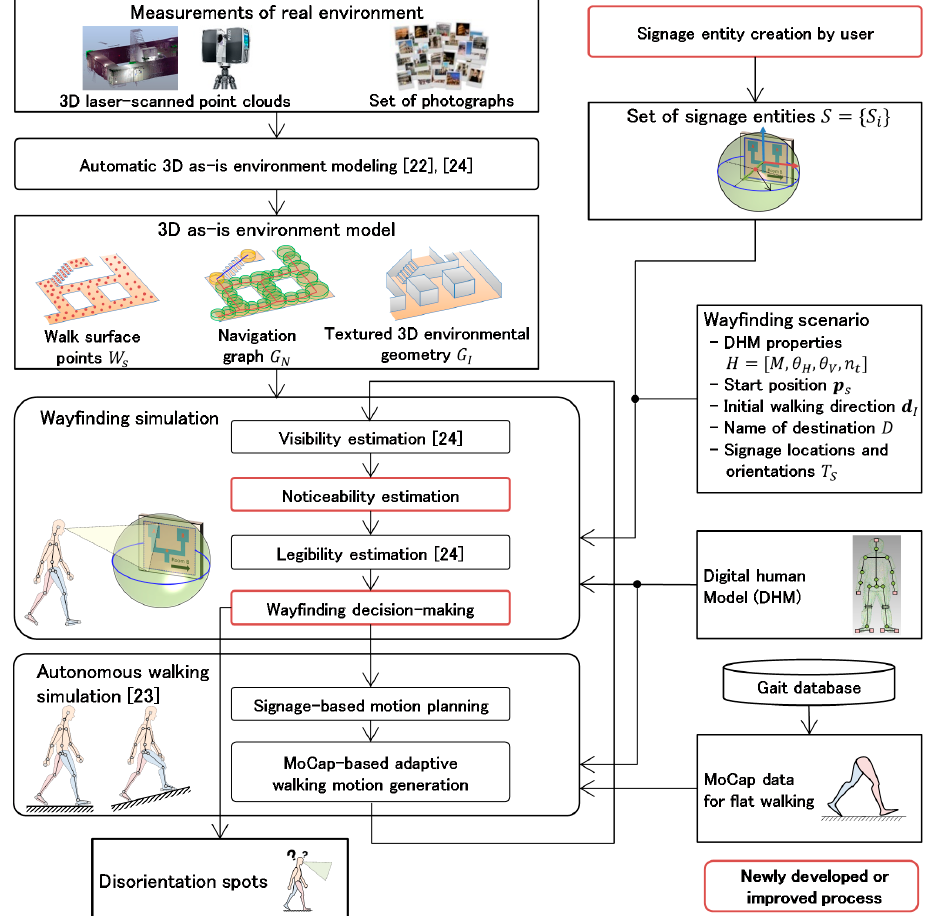
Figure 1. Overview of system for evaluating ease of wayfinding.